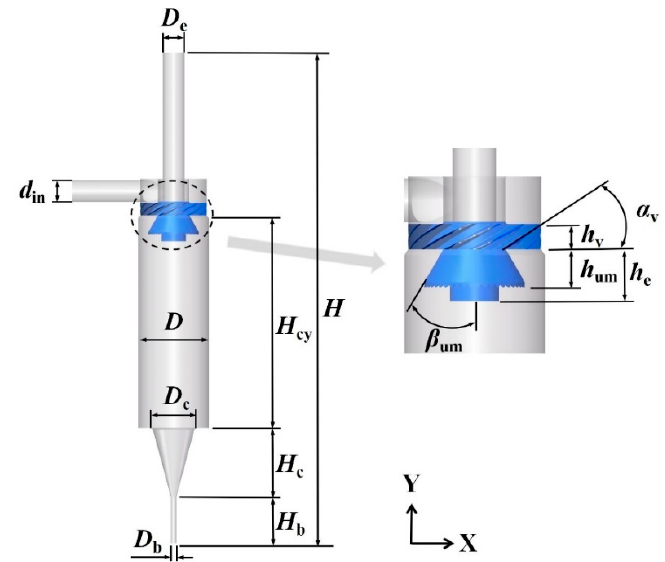
Table 1. Main structural parameters of cyclone separators.